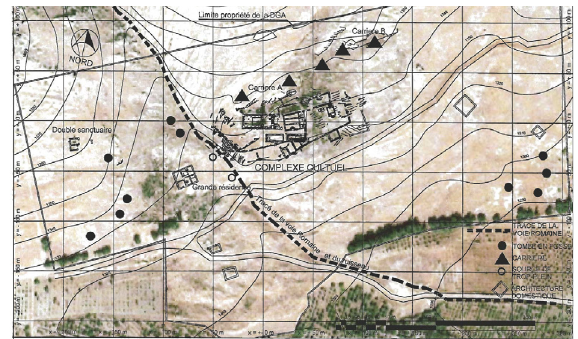
Figure 5. The site of Hosn-Niha and its various remains. Map © J. Yasmine; January 2007.